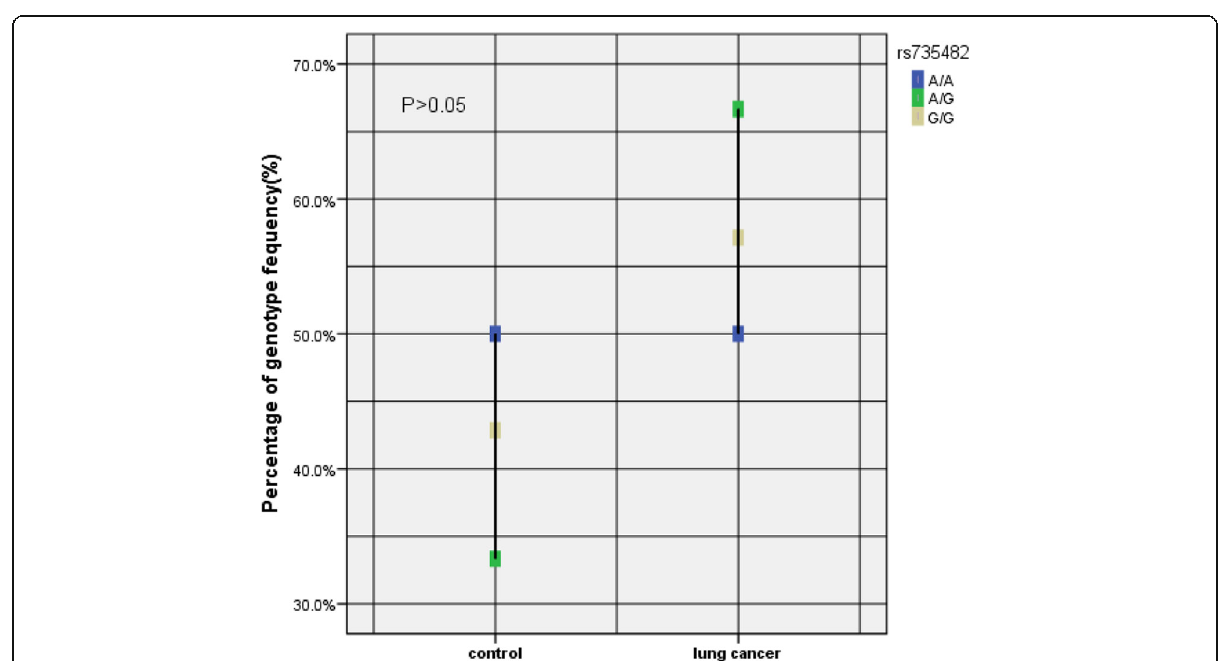
Fig. 3 Percentage of rs735482 genotypes frequency in lung cancer patients and controls